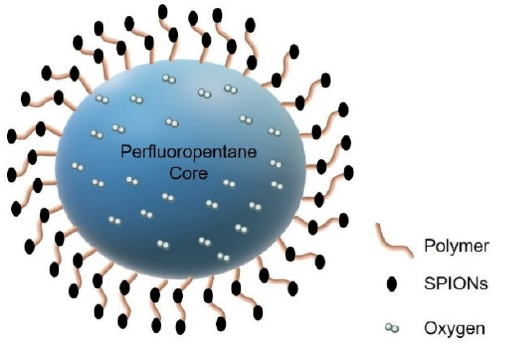
Figure 7. Illustration of MOLNBs (negatively charged dextran shell NBs decorated with positively charged SPIONs by electrostatic charged SPIONs by electrostatic interaction).